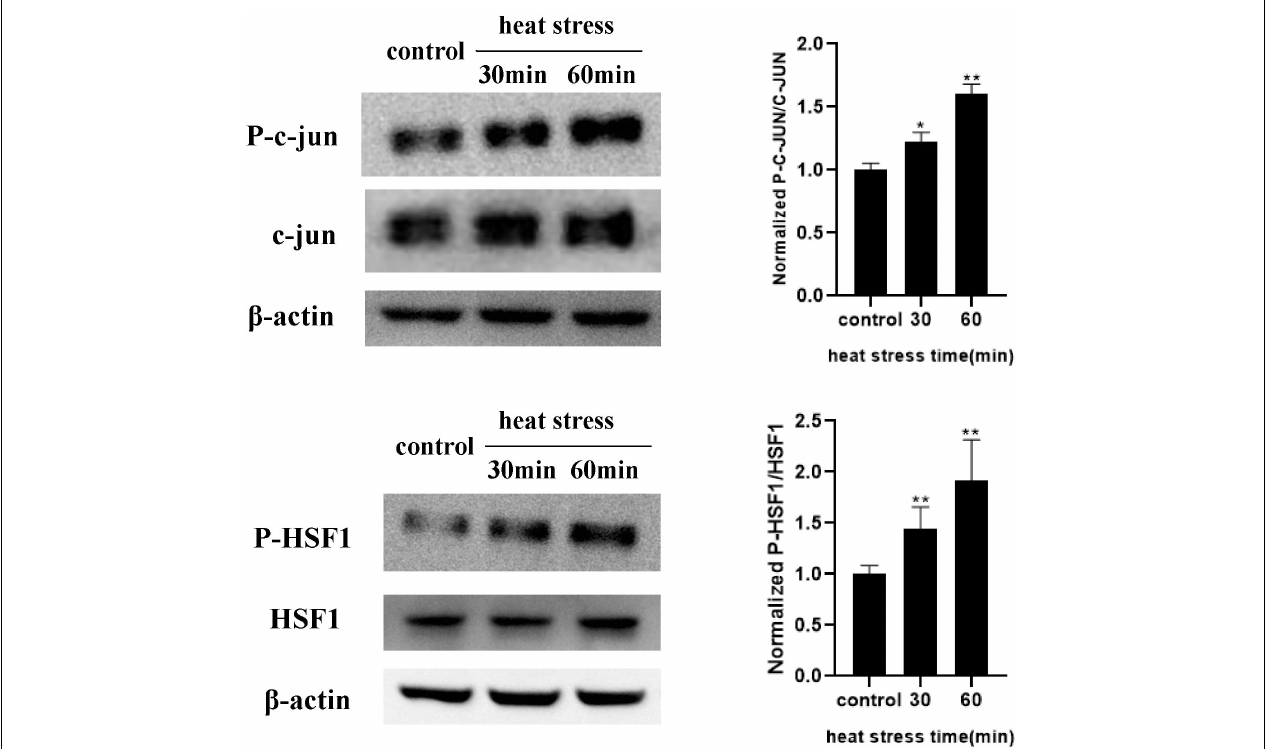
FIGURE 6 | Influences of heat exposure on the protein expression and phosphorylation levels of HSF1 and c-Jun. HUVECs were subjected to heat stress at 42 ◦ C for 30 min or 1 h, and HSF1 and c-Jun phosphorylation post heat stress were determined by western blot. Representative images of western blot and quantitative analysis of phosphorylation levels of HSF1 and c-Jun normalized to total c-Jun were shown above (* P < 0.05 vs control, ** P < 0.01 vs control).